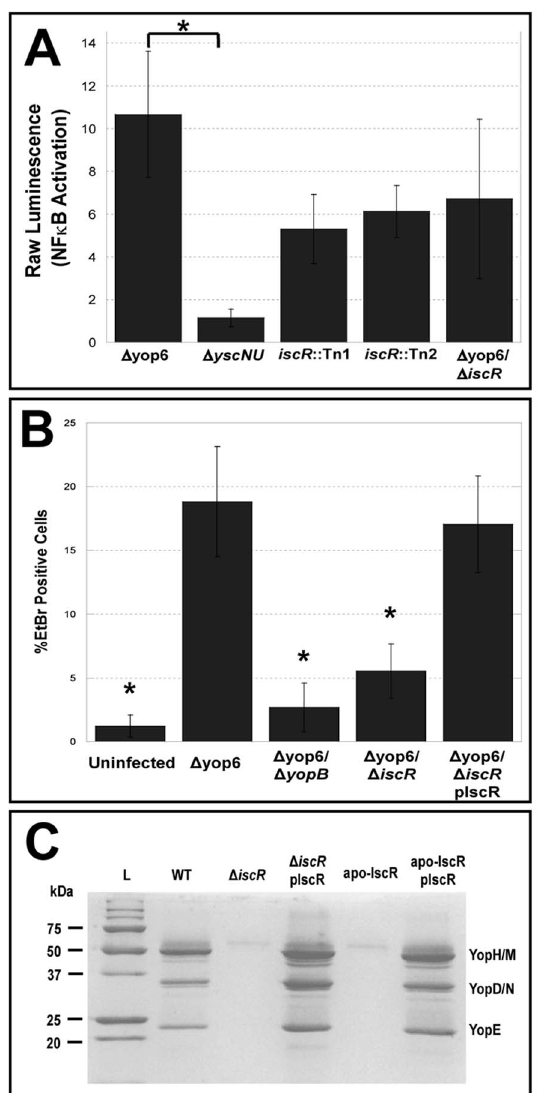
Figure 2. IscR modulates Y.pseudotuberculosis T3SS function. ( A ) HEK293T cells expressing an NF k B luciferase reporter gene were infected with either T3SS-positive Y. pseudotuberculosis lacking the six known effector proteins YopHEMOJT ( D yop6), two isogenic iscR transposon mutants ( D yop6/ iscR ::Tn1 and D yop6/ iscR ::Tn2), the iscR deletion mutant ( D yop6/ D iscR ), or a T3SS null mutant ( D yscNU ). At 4